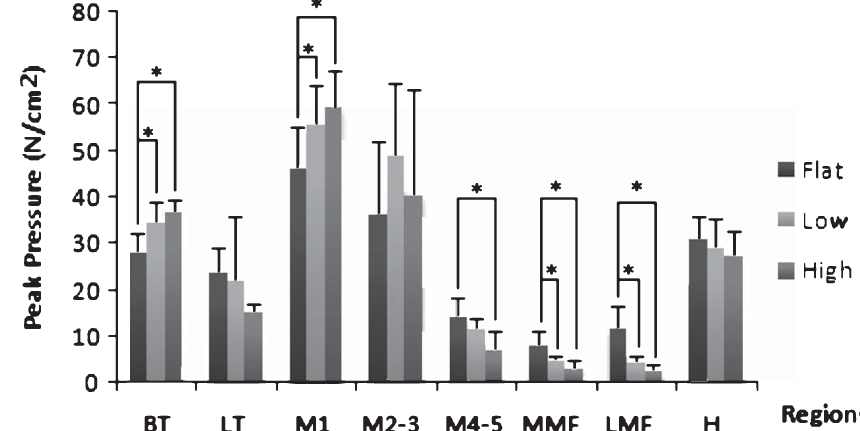
Fig. 2. Maximum force during jogging with different heel heights. ∗ indicates significant difference ( p <0.05).